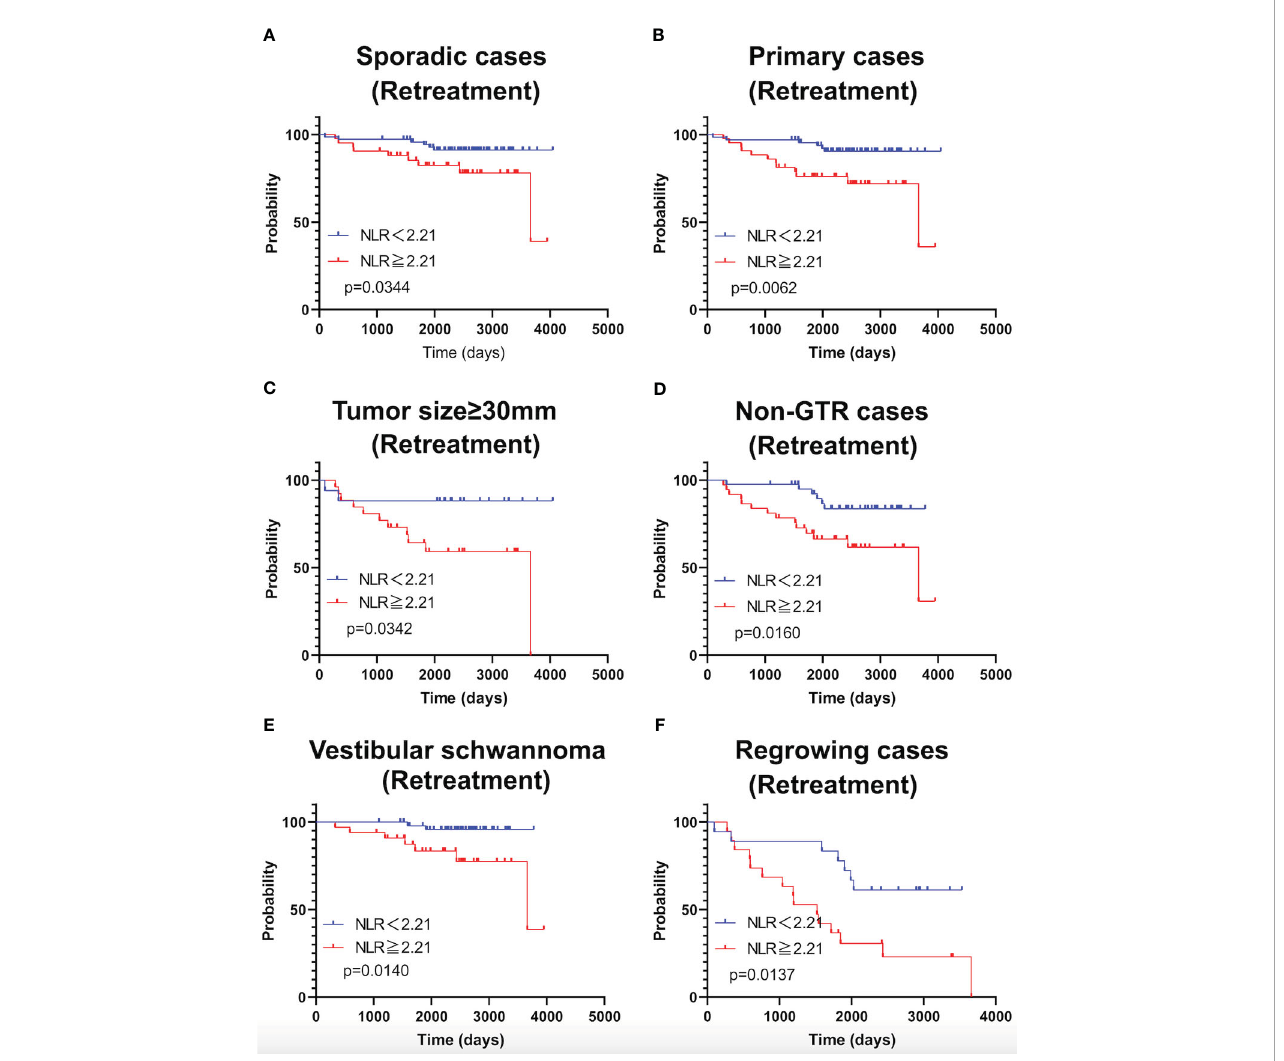
FIGURE 4 Kaplan-Meier curves of TFS related to sporadic cases (A) , primary cases (B) , large tumor ( ≥ 30mm) (C) , Non-GTR cases (D) , cases with vestibular schwannomas (E) , and growing cases (F) are